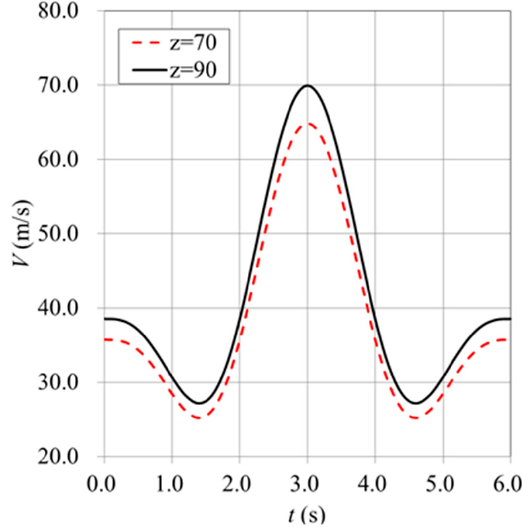
Figure 8. Time history of wind speed in a gust period. Table 1. Wind speed